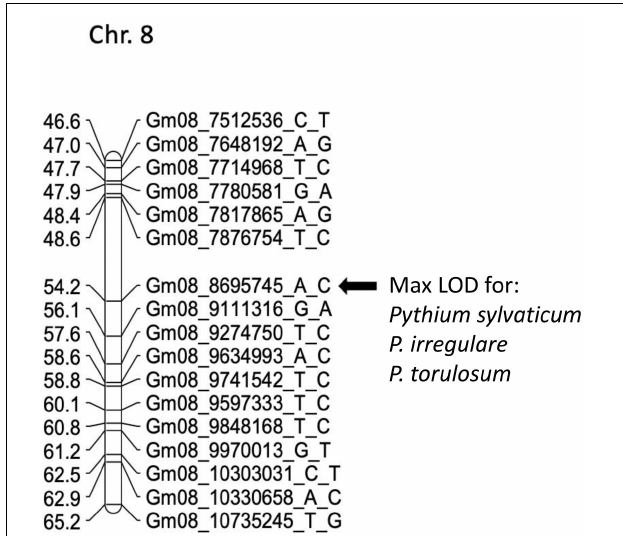
FIGURE 1 | Schematic representation of a regional linkage map of chromosome 8 for POP3 with the map position for the QDRL for resistance to Pythium sylvaticum , P. irregulare , and P. torulosum highlighted. The SNP markers are identified on the right side and cM distances are on the left side. The closest SNP marker to the QDRL is shown by an